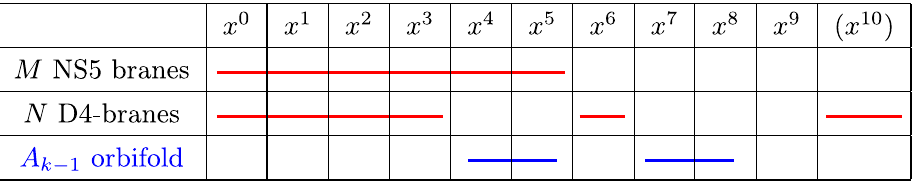
Figure 1 . Type IIA brane con(cid:12)guration for the 4D N = 1 theories of class S k . The A k (cid:0) 1 orbifold acts on the 45 and 78